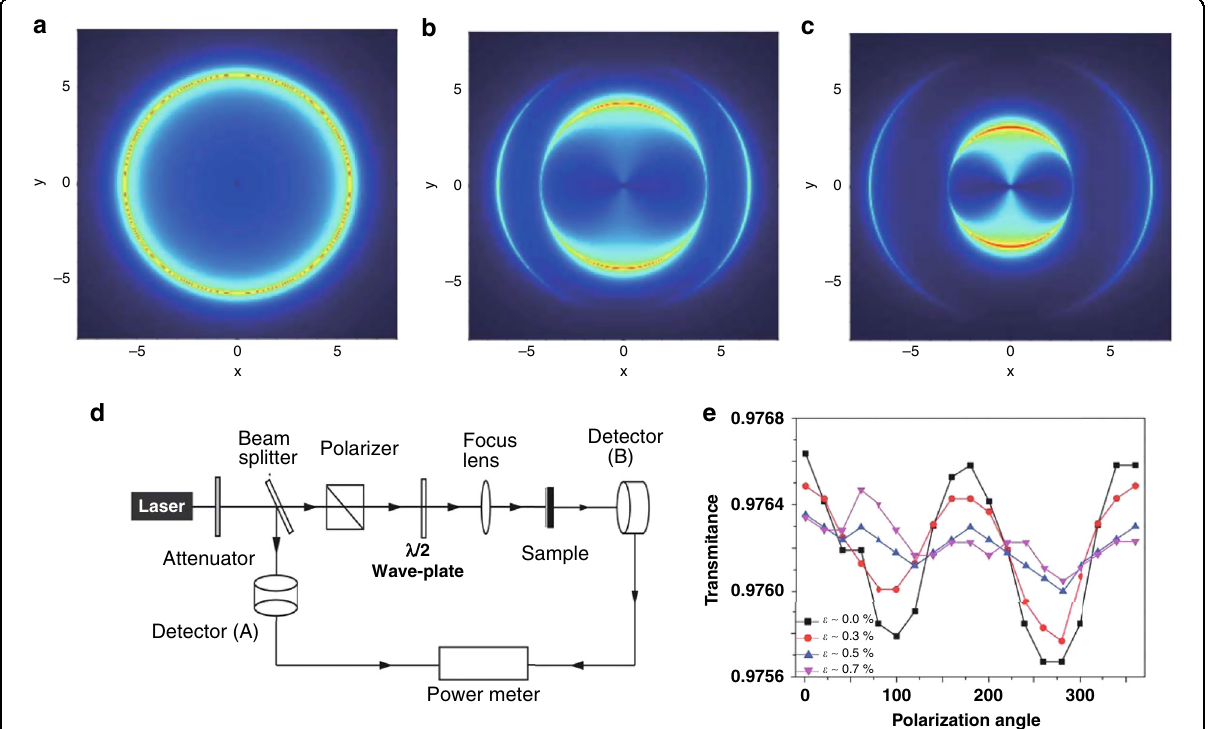
Fig. 6 Strain-induced anisotropic optical effects in graphene. a – c Polar plots of the longitudinal optical conductivity as a function of frequency ( ω > 0, polar axis) and electric fi eld orientation ϕ (polar angle). Strain is applied along the armchair direction, and increases from a to c ( ε = 0, 0.075, and 0.175) 47 . d Schematic of the absorption measurement setup for graphene 114 . e Polarization-resolved optical transmittance of strained graphene 114 . Reprinted a – c with permission from ref. 47 . Copyright (2010) by American Physical Society. Reprinted d and e from ref. 114